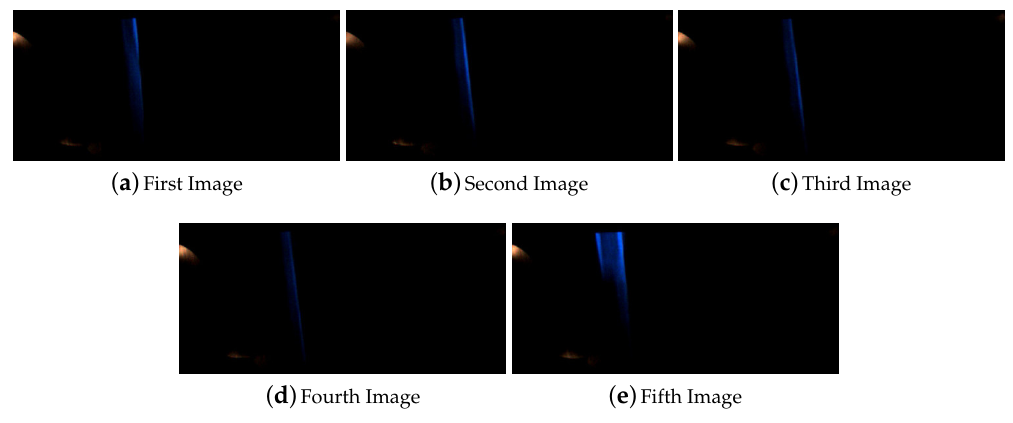
Figure 15. Sequence of images for the reduction of the line width to 2.5